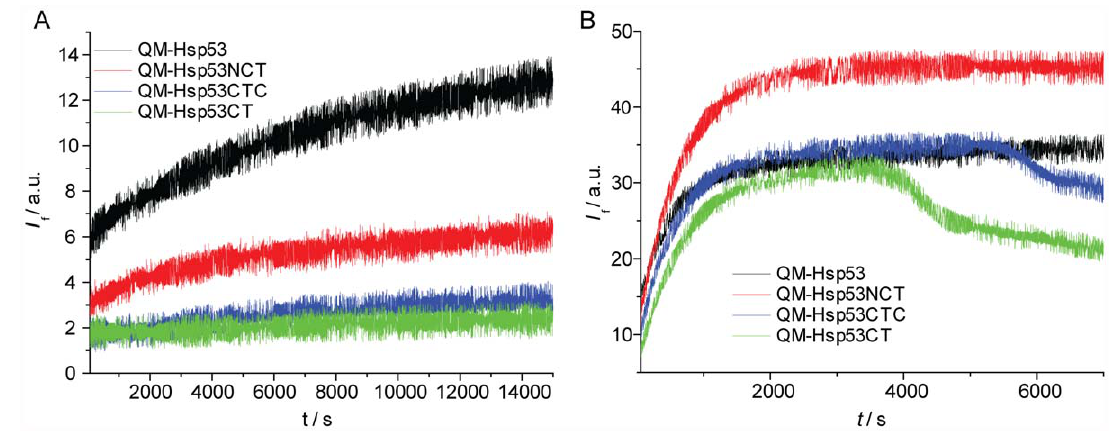
Figure 2. ITDF results for QM-Hsp53 constructs. A: Measurement at 38 u C, full-length QM-Hsp53 in black and a construct missing the C-terminus (QM-Hsp53NCT, red) exhibit the second, faster unfolding event. Constructs missing the N-terminus (QM-Hsp53CTC, blue; QM-Hsp53CT, green) do not exhibit any significant unfolding. B: Measurement at 45 u C using the same colour coding as in ‘A’. Fluorescence drops are only seen for constructs missing the N-terminus of p53.